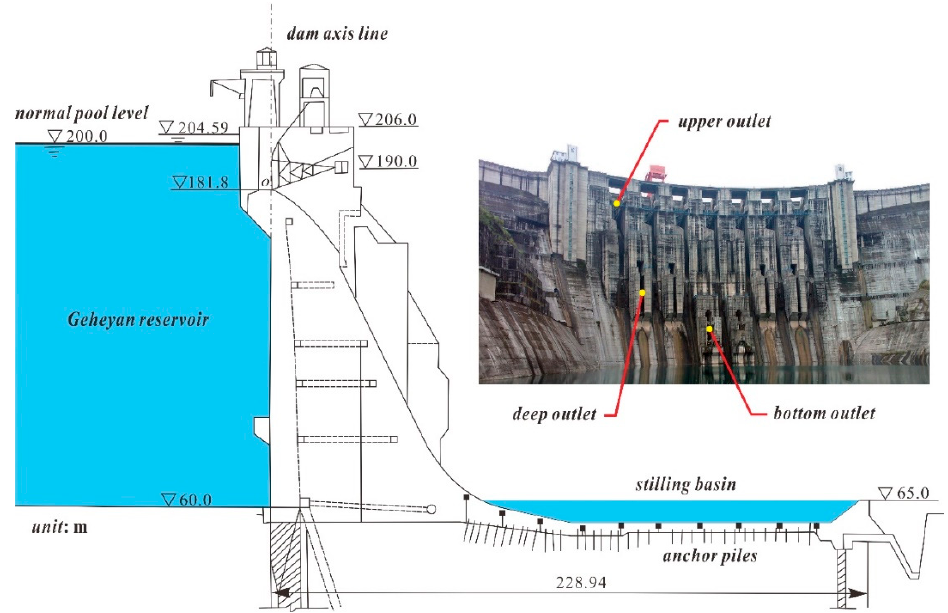
Figure 5. Side and front views of main Geheyan dam structure.